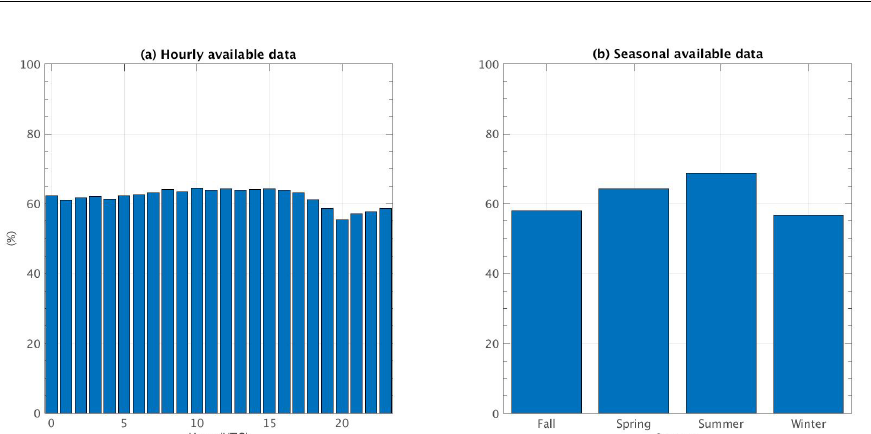
Figure 1. Histograms of (a) hourly and (b) seasonal available data in the SIRTA-ReOBS dataset, considering all the variables needed for the period of study 2009–2014 for the temperature variation